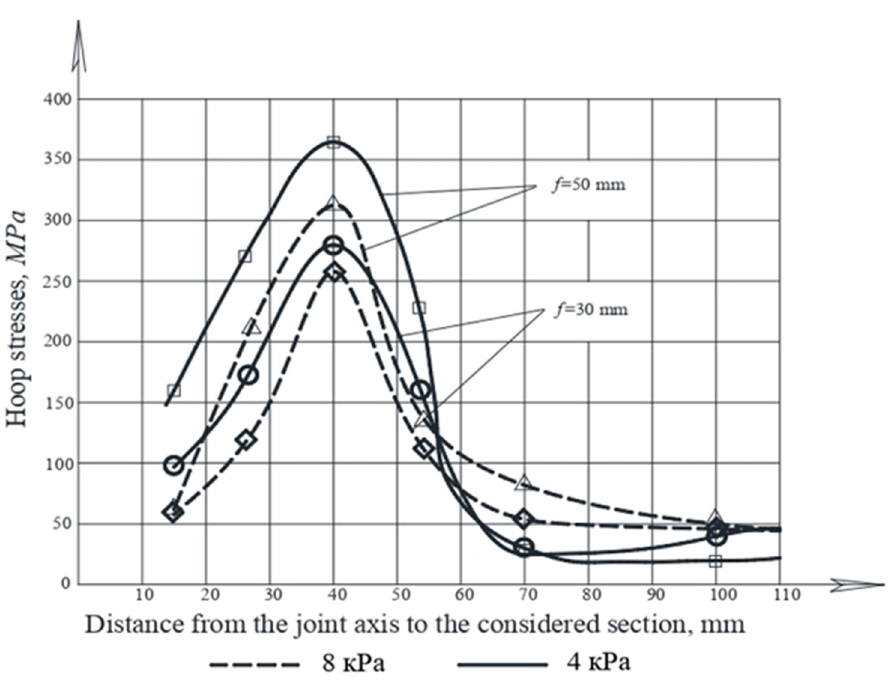
Figure 7. Distribution of the hoop stresses in the joint zone with the wall bend in the joint point f equal to 30 mm and 50 mm.